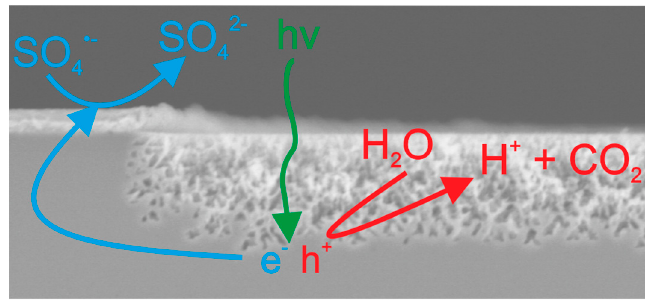
Figure 1. Schematic depiction of the mechanism of